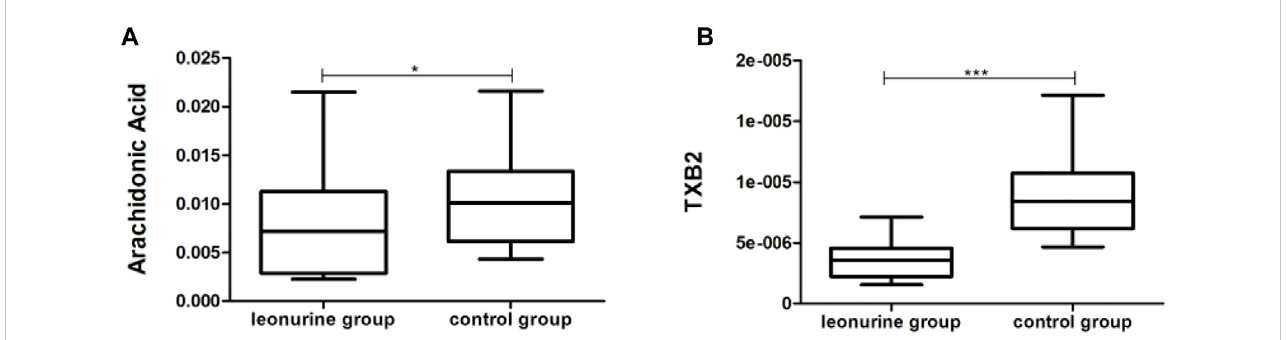
The signi fi cantly down-regulated metabolites in moDCs with leonurine administration (HD-moDCs, n = 15). 2 metabolites as shown in the above boxplots (A,B) were signi fi cantly down-regulated in the leonurine group than in the control